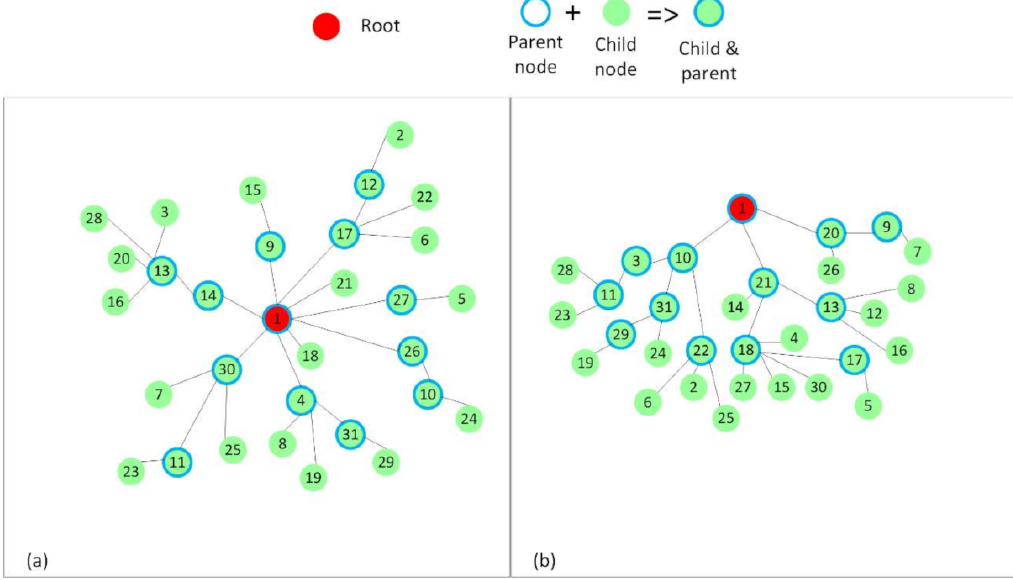
Figure 6. The RPL trees or topologies formed with a random placement of nodes. ( a ) The root node is placed in the center of the network. This topology is 3 hops deep. ( b ) The root node is placed at the top of the topology. This topology is 4 hops